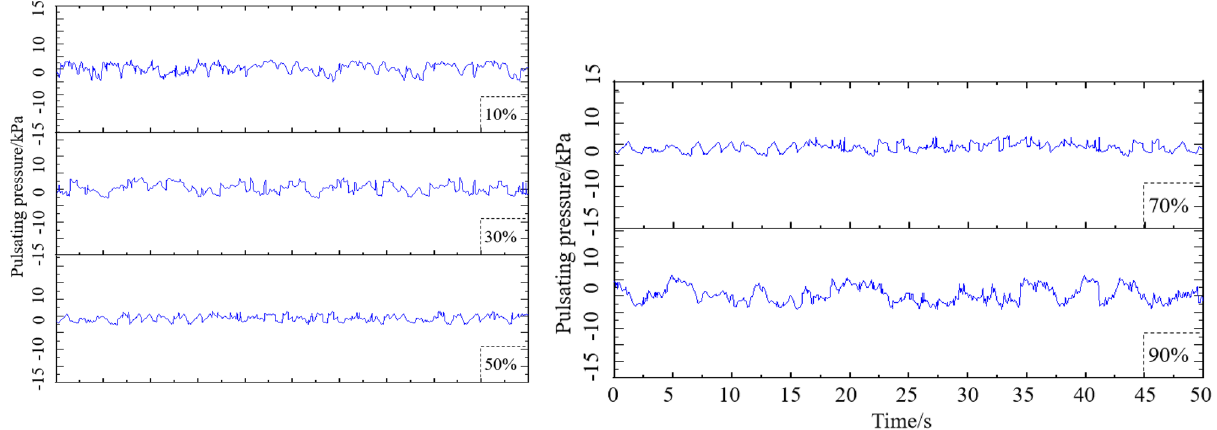
Figure 2. Time history of selected typical fluctuating hydrodynamic pressure.